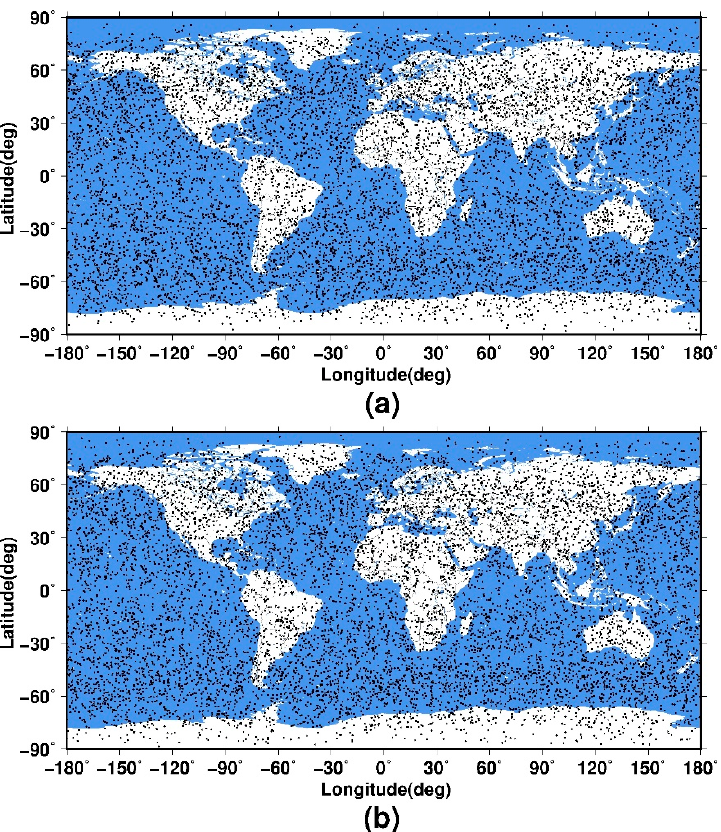
Figure 1. The simulated 24 h Global Navigation Satellite System (GNSS) radio occultation events (ROEs), observed by COSMIC using the real orbits ( a ) and the simulated orbits ( b ).